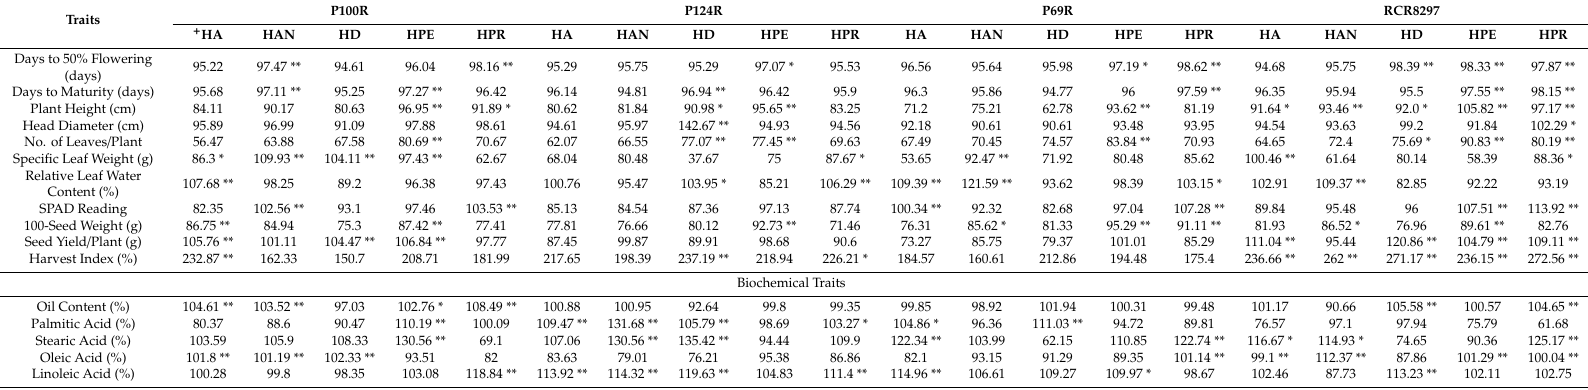
Table 5. Heterosis over commercial check values (%) among CMS sources representing five di ff erent species of sunflower for morpho-physiological, yield and biochemical traits under normal irrigation.